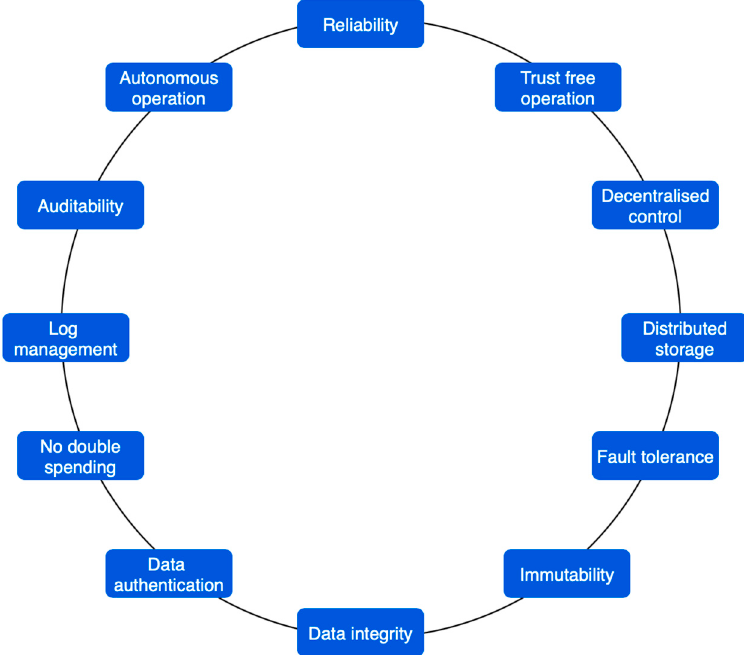
Figure 2. Characteristics of blockchain—IoT-based applications [4].